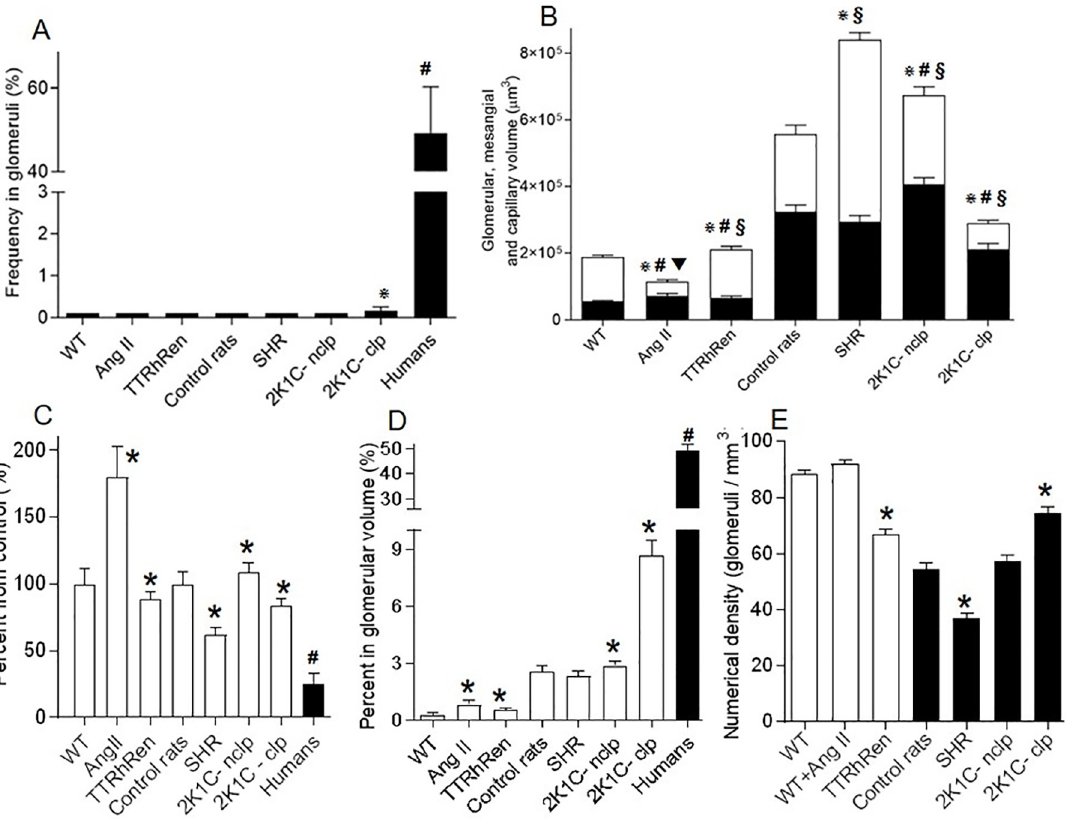
Fig 3. Glomerular lesions in hypertensive animal models were much lower compared to humans. A Frequency of hyalinosis/focal segmental glomerulosclerosis is presented as the percentage of positively stained tufts. Among samples, only the clipped kidney (2K1C- clp) demonstrated lesions ( ⋇ P < 0.01 vs control) that remarkably lower than human values (# P < 0.0001 vs 2K1C-clp). B Morphometric data of the mesangial, capillary and glomerular volumes. The whole bar represents the glomerular volume as the sum of the mesangial (black part) and capillary (white part) volumes. P < 0.01 vs control for mesangium ( ⋇ ), capillary (#), and glomerular (§) volumes respectively. C Mesangial cellularity markedly increased in angiotensin II infused mice (Ang II) and decreased in spontaneously hypertensive rats (SHR) ( ⋇ P < 0.001 vs control) but still far from hypocellularity observed in human glomerulosclerosis (# P < 0.001 vs SHR). D The collagen-positive area in glomeruli. P < 0.001 vs control ( ⋇ ). TTRhRen—renin overexpressing mice; 2K1C-nclp—non- clipped kidneys. Human data are reference values from Table 1. E Genetic models of hypertension demonstrated lower number of nephrons. P < 0.01 vs control ( ⋇ ). Each column consists of mean ± SEM.